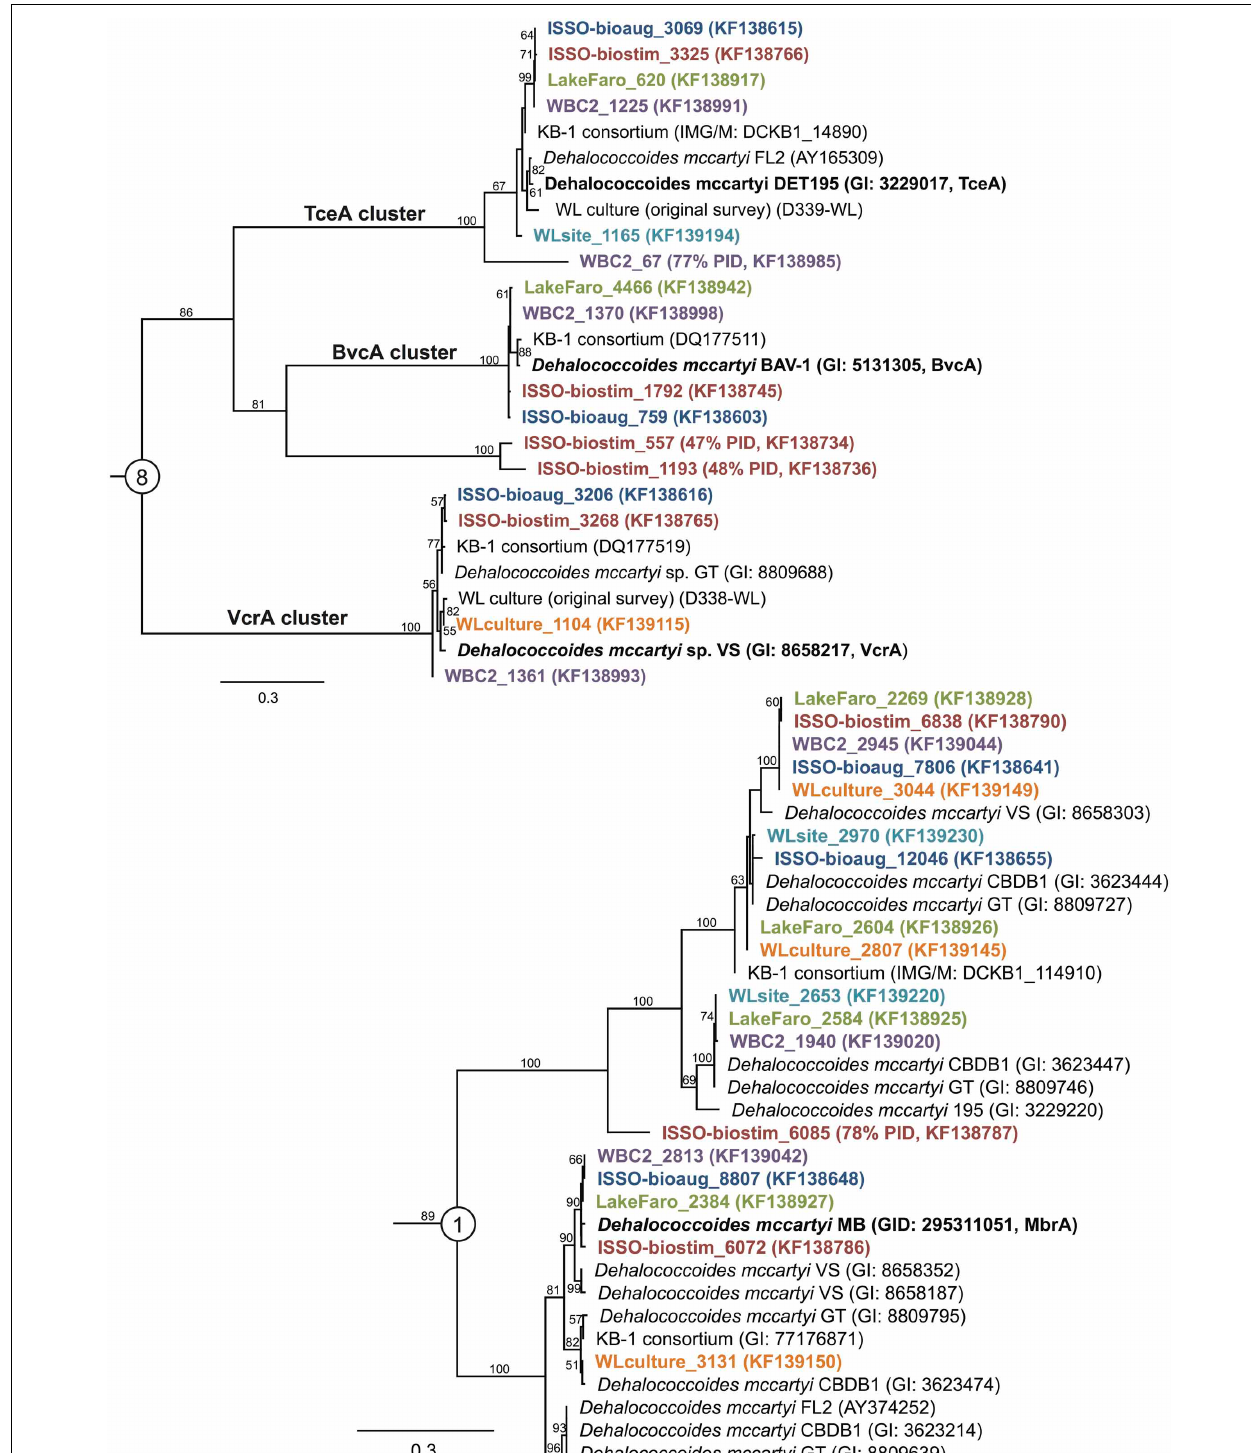
FIGURE 3 | Reductive dehalogenase homologs are broadly distributed, including homologs to enzymes of known function. Maximum likelihood trees of newly sequenced RdhA with best homology match to RdhA sequences from primer groups 8 and 1, including the characterized chloroethene dehalogenases BvcA, VcrA, and TceA (group 8) and MbrA (group